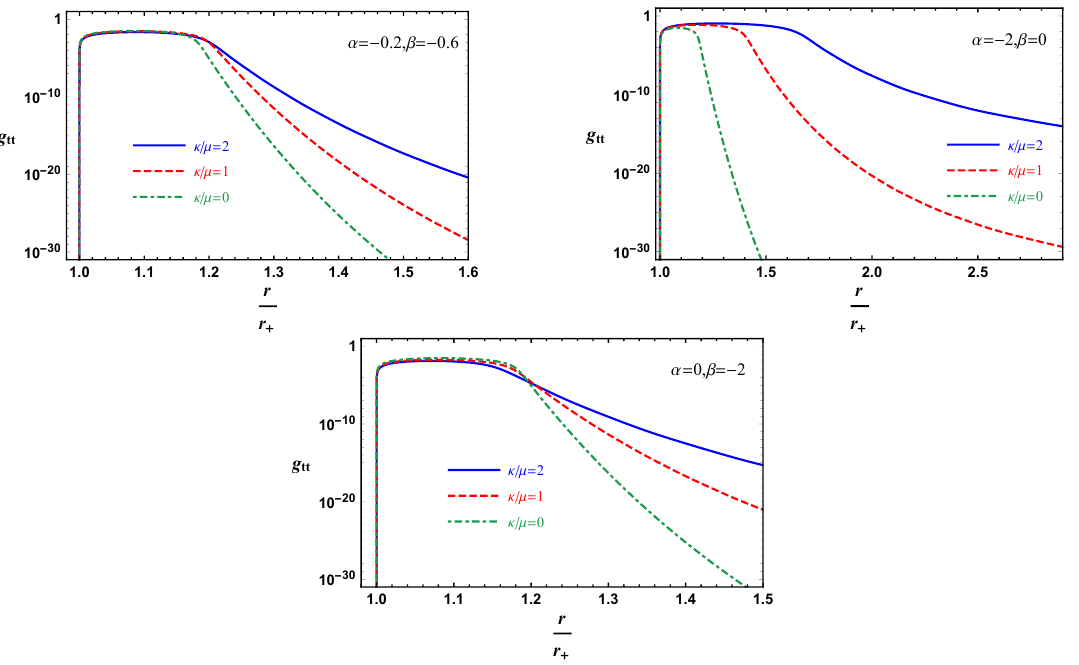
Figure 4 . Metric component g tt as a function of r near the collapse of the ER bridge for various values of κ/µ . Here we take T/T c = 0 . 995